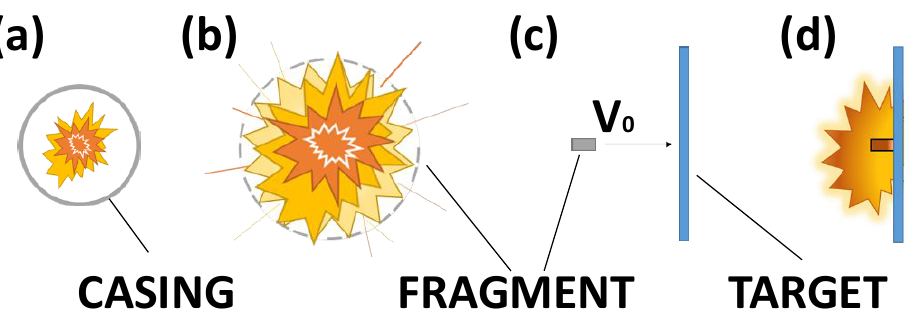
Figure 1. Schematic representation of bomb detonation ( a ); case fragmentation ( b ); fragment flight accelerated by the blast ( d ); impact with target and impact-induced energy release ( c ).